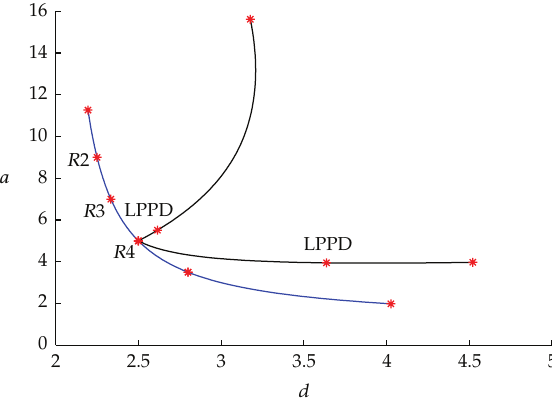
Figure 7: Twofold curves (cid:3) LP 4 (cid:4) emanate from an R4 point on an NS